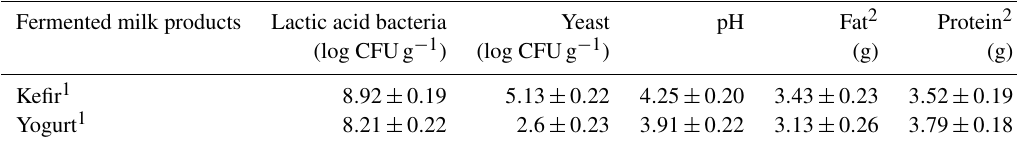
Table 2. Analysis of the chemical and microbiological composition of kefir and yogurt. Fermented milk